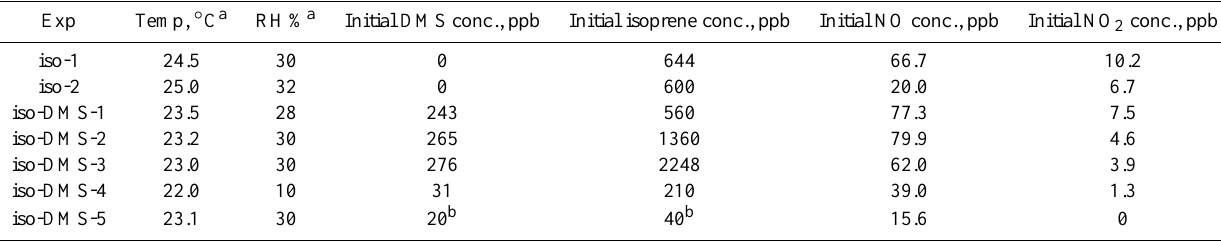
Table 1. Chamber experiments of the photooxidation of DMS and DMSO in the presence of NO x . Exp Temp, ◦ C ∗ RH% a Initial sulfur conc., ppb Initial NO conc., ppb Initial NO 2 conc., ppb DMSO-1 22 24 291.3 47.9 1.1 DMSO-2 22 26 306.5 199.1 0 DMSO-3 21 23 99.1 32.0 1.0 DMSO-4 24 24 170.0 79.7 5.3 DMSO-5 26 27 75.7 32.0 1.0 DMS-1 24 28 714.0 102.7 1.0 DMS-2 26 28 210.0 116.8 3.1 DMS-3 25 28 146.0 25.4 1.0 DMS-4 27 40 134.0 21.5 0.5 DMS-5 25 60 161.0 61.9 0